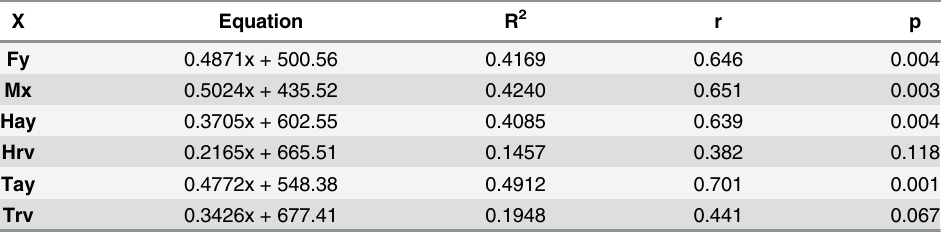
Table 3. Parameters from regression between threshold amplitudes obtained using each of the physi- ological measures and that obtained from the joystick (x). P-values are for the slope of the regression equation (n =